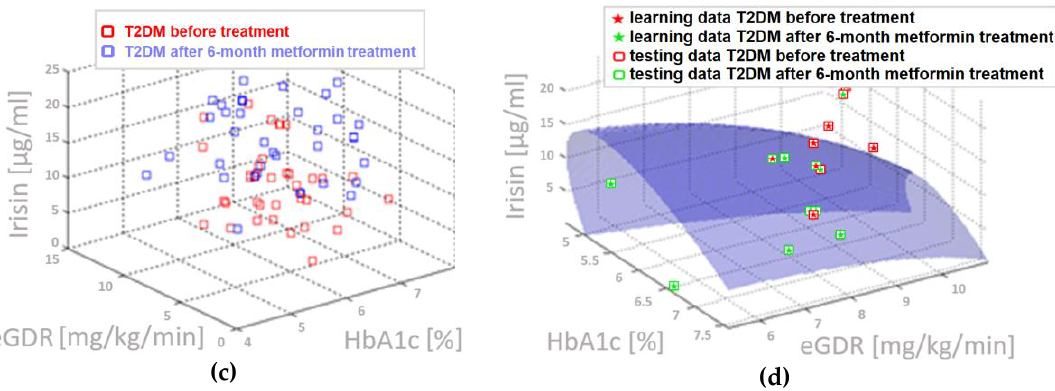
Figure 2. Three-parameter discriminant analysis, which allow to differentiate metabolic state of T2DM patient before treatment and after 6-month metformin therapy: ( a ) adropin, irisin, and vaspin data set obtained diabetic patients ( b ) graph of the discriminatory curve which based on adropin, irisin and vaspin allows for separation between metabolic state od diabetic patients before and after metformin treatment; ACC = 69 [%] ( c ) irisin, HbA1c, and eGDR data set obtained from diabetic patients; and, ( d ) graph of the discriminatory curve, which, based on irisin, HbA1c, and eGDR, allows for separation between metabolic state od diabetic patients before and after metformin treatment; ACC = 80 [%] .